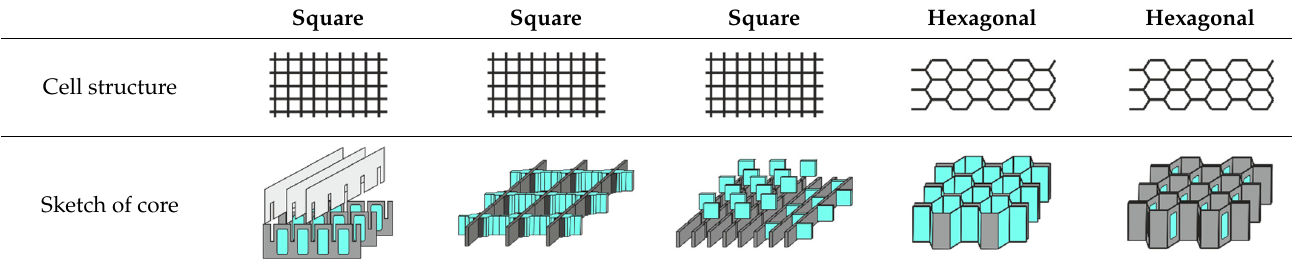
Table 1. Design variants of new acoustic liners.